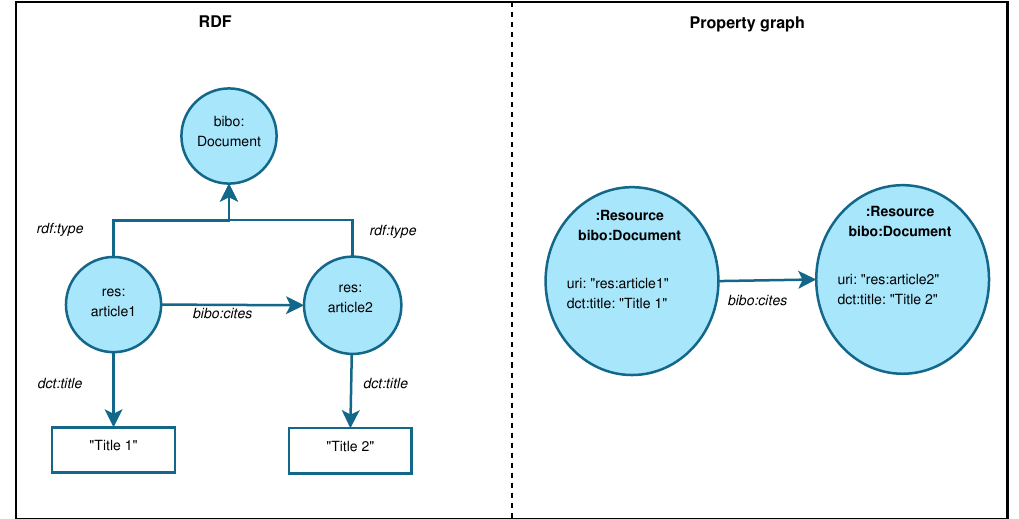
Figure 5. RDF and property graph